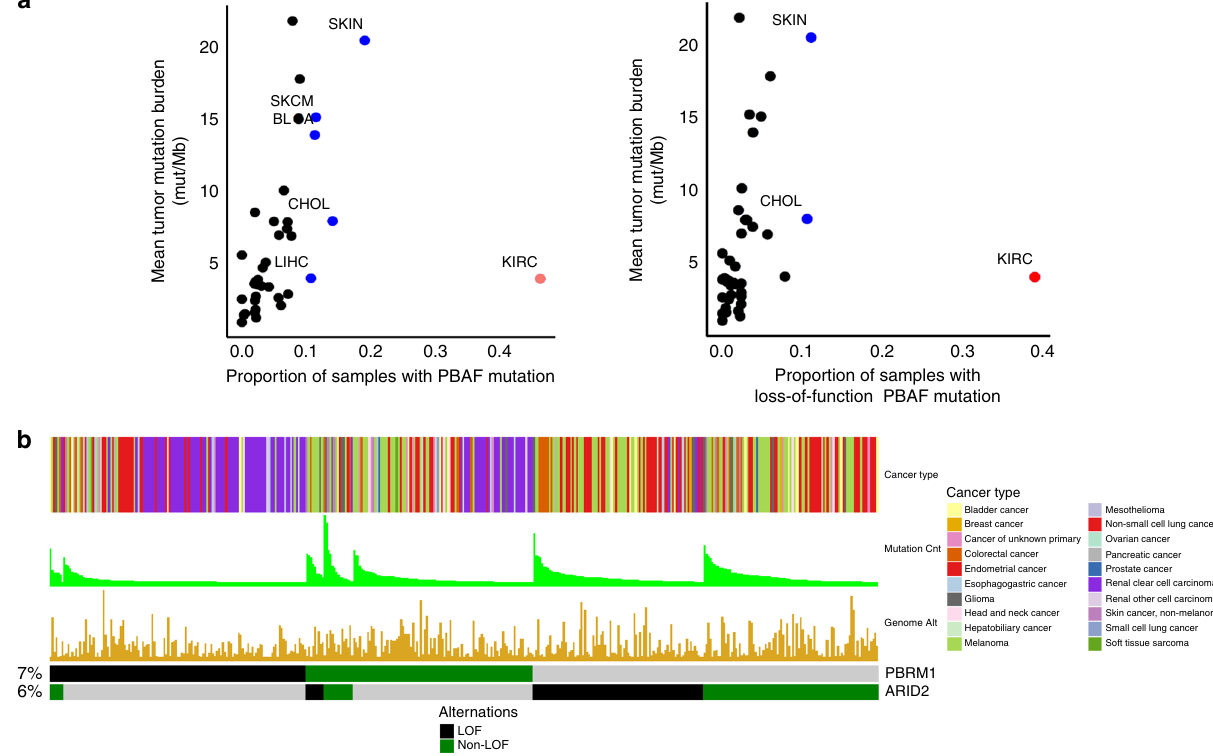
Fig. 3 PBAF ( PBRM1 and ARID2 only) complex mutations across MSK-IMPACT ( n = 3700). a All PBAF complex mutations as a function of mean tumor burden (left) and loss of function (LOF) only mutations (right). b OncoPrint plot demonstrating loss-of-function vs. non-loss-of-function PBAF complex mutations across MSK-IMPACT. Table 2 Characteristics of 189 patients with clear cell RCC treated with ICB